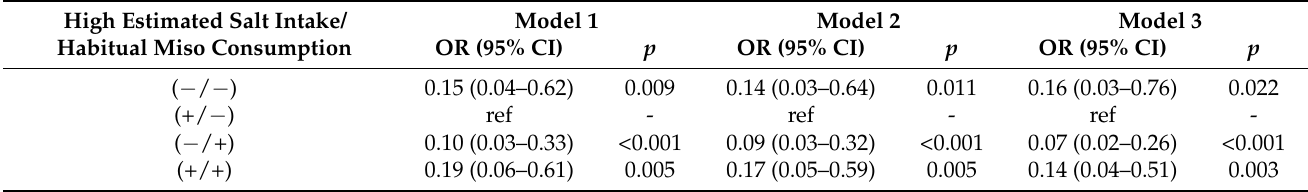
Table 3. Odds ratio of the presence or absence of high estimated salt intake or habitual miso consumption for presence of obesity. High Estimated Salt